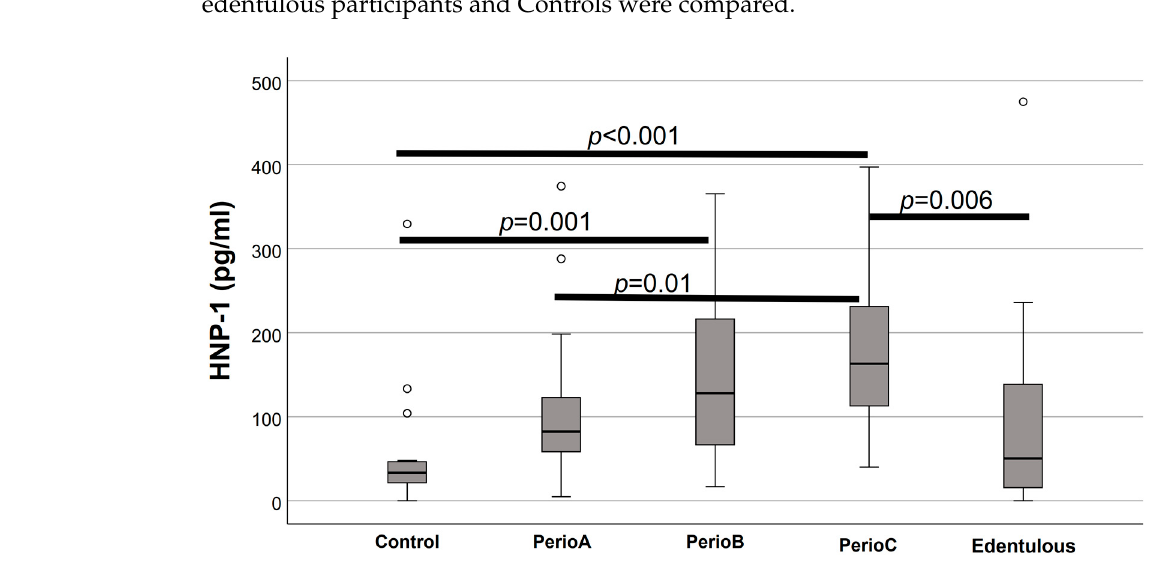
Figure 1. Salivary human neutrophilic peptide (HNP)-1 levels in relation to the extent of periodontal destruction. Significant differences between the groups are marked with connector lines and p values are denoted above (the empty circles indicate outliers).